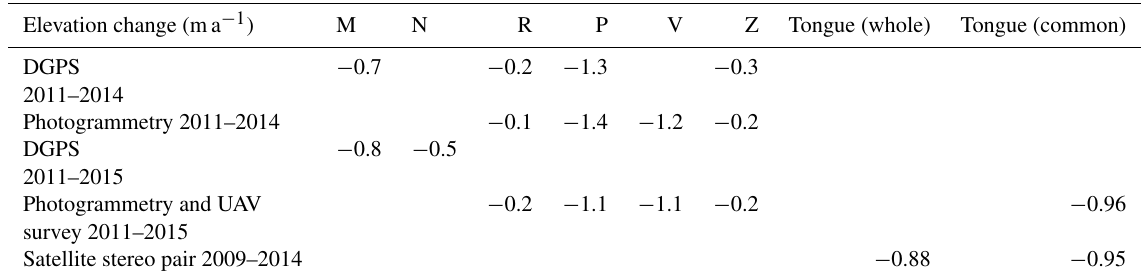
Table 1. Mean elevation changes (ma − 1 ) estimated from repeat DGPS measurements and DEM differencing (photogrammetry, UAV and satellite) on cross sections and over the debris-covered tongue (entire and common areas). The letters M to Z refer to cross sections as in Fig.